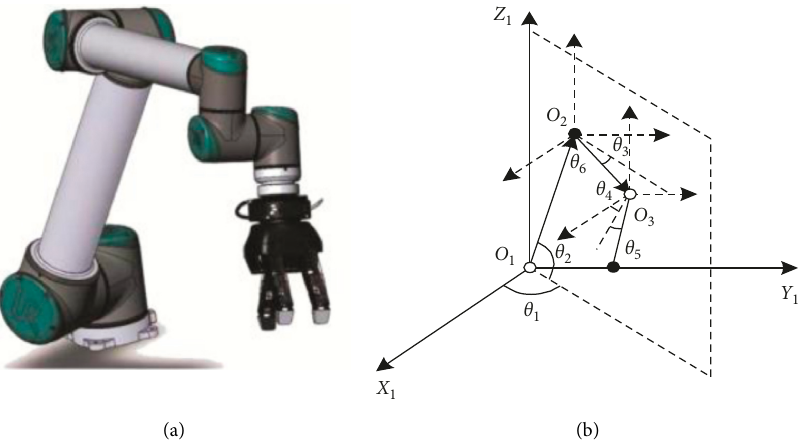
Figure 1: Diagrams of the manipulator and its simplified model in the Cartesian coordinate system. (a) UR10 manipulator. (b) Simplified